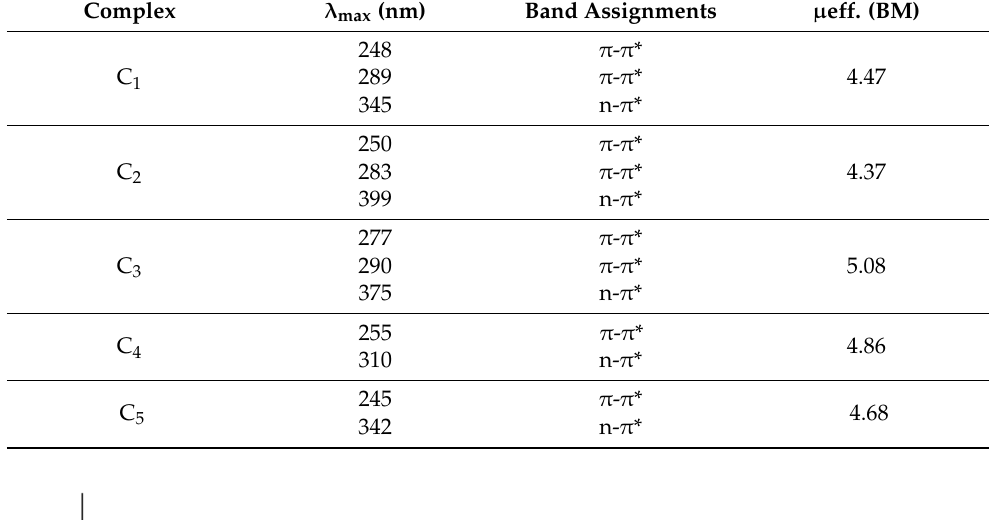
Table 2. Electronic spectral and magnetic moment values for Co(II)-Schiff base metal complexes.